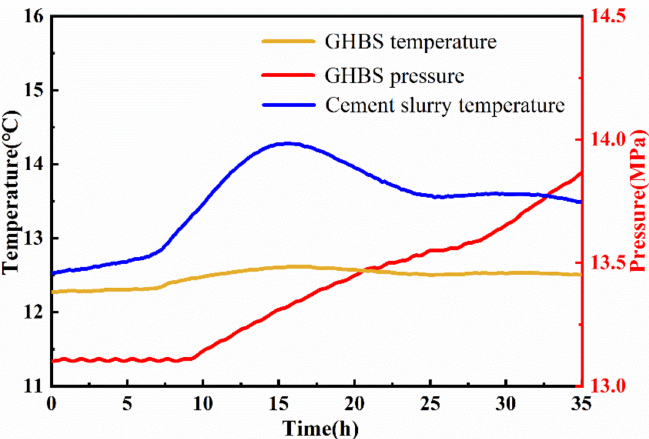
Figure 20. Damage of GHBS caused by hydration heat of CS.